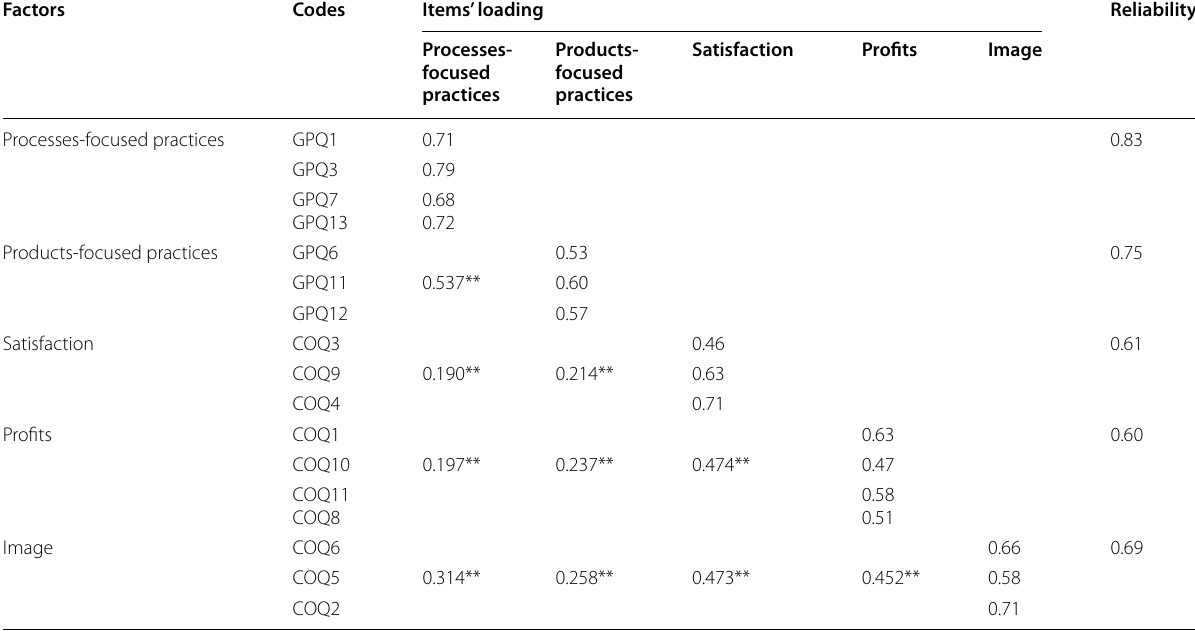
**Correlation is significant at the 0.01 level (two tailed)